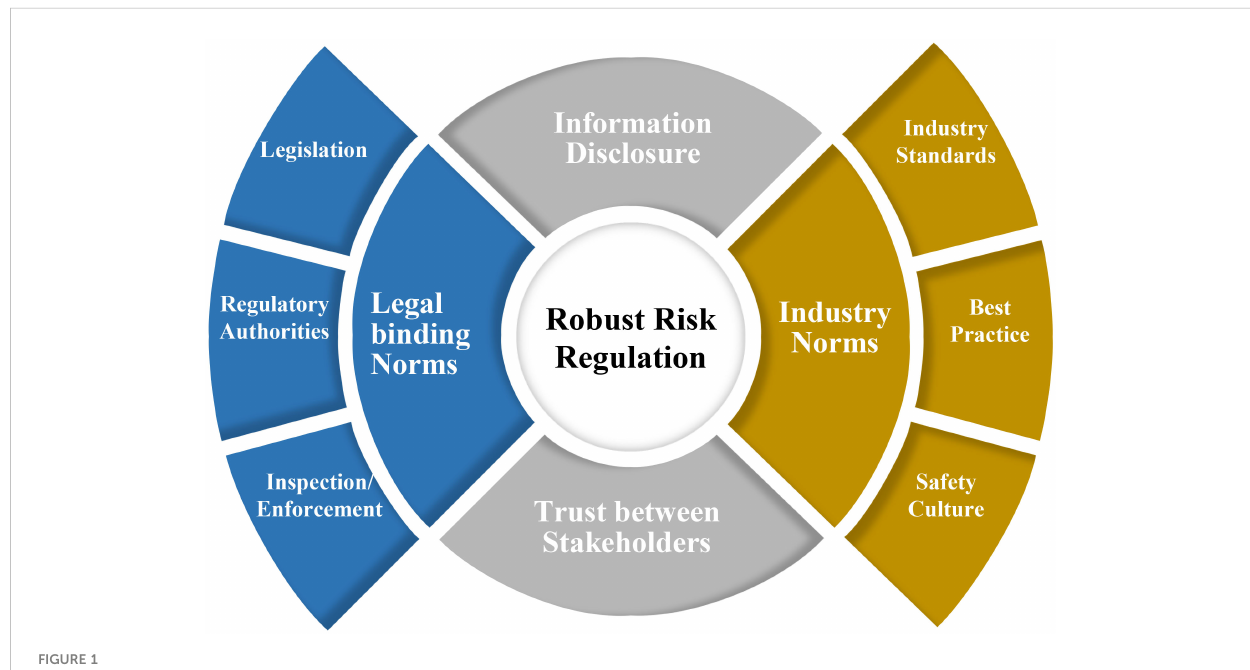
FIGURE 1 The scope of robust risk regulation of offshore drilling